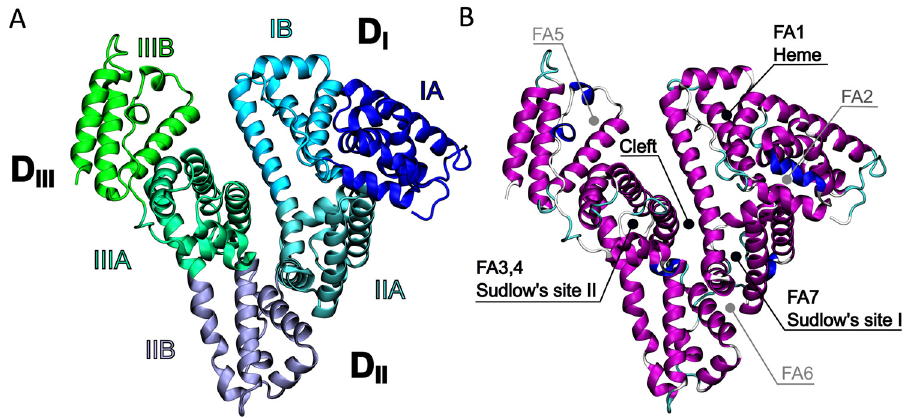
Figure 1. The 3D structure of HSA: ( A ) Subdivision into domains (I–III) and subdomains (A, B); ( B ) identification of the binding sites.